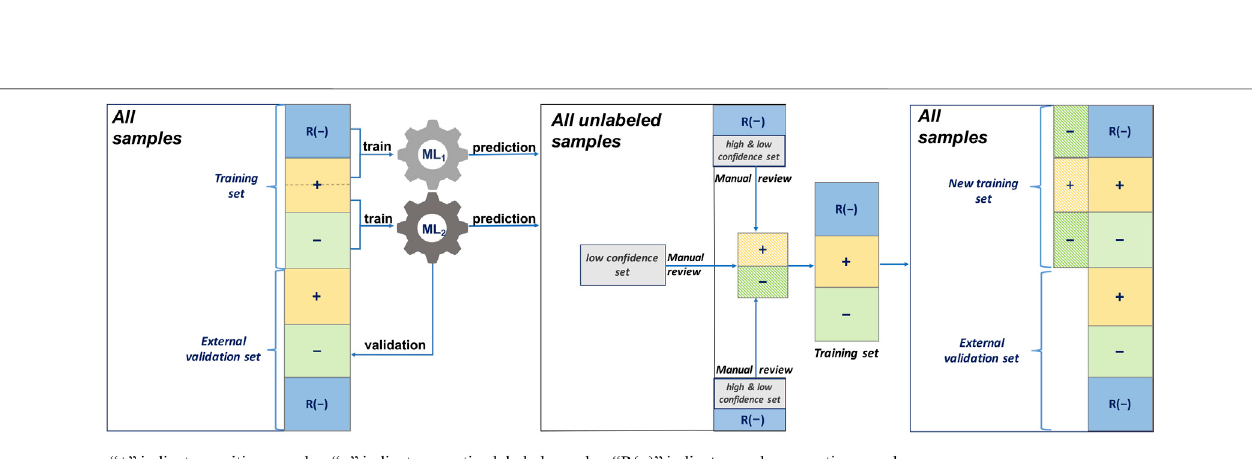
Frontiers in Pharmacology |